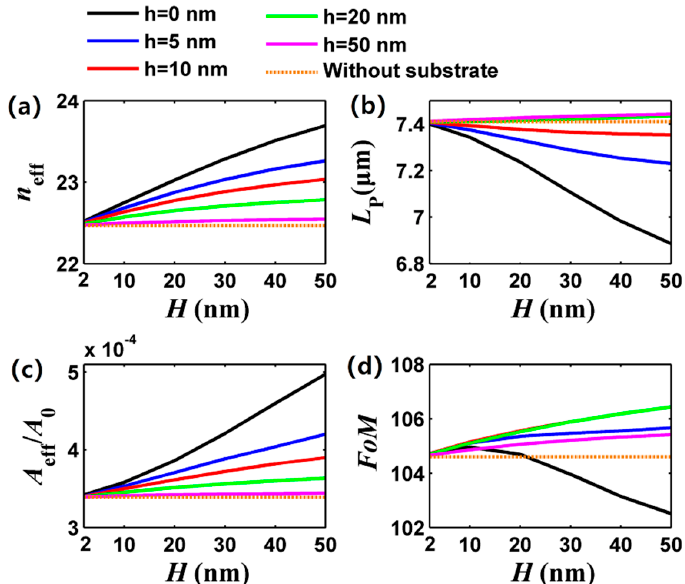
Figure 3. Dependence of the FGPM properties on gap size h and substrate thickness H at 30 THz. ( a ) Effective mode index; ( b ) propagation length; ( c ) normalized mode size; and ( d ) FoM. Other parameters are the same as Figure 2.